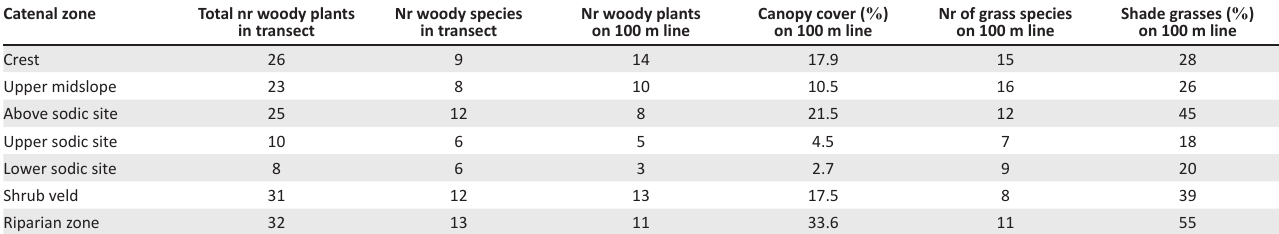
TABLE 1: Numbers of individual woody plants and woody species present in each transect (3.5 m × 100 m). The total number of woody plants indicates all individuals where the crown only, or crown and trunk (rooted), was within the transect. Canopy cover and the number of plants directly on the line were indicated for all woody species where the crown covered the 100 m measuring tape. The number of grass species and percentage of grasses that grow in the shade, determined by hits of the point method on the 100 m line, are also indicated. Catenal zone Total nr woody plants Nr woody species in transect in